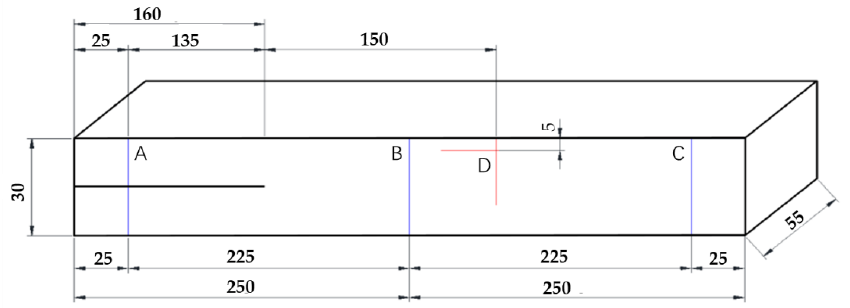
Figure 1. Schematic diagram and dimensional parameters of engineered bamboo specimens (unit: mm). A, B, C: orientation line for specimen installation positioning; D: data analysis reference point.